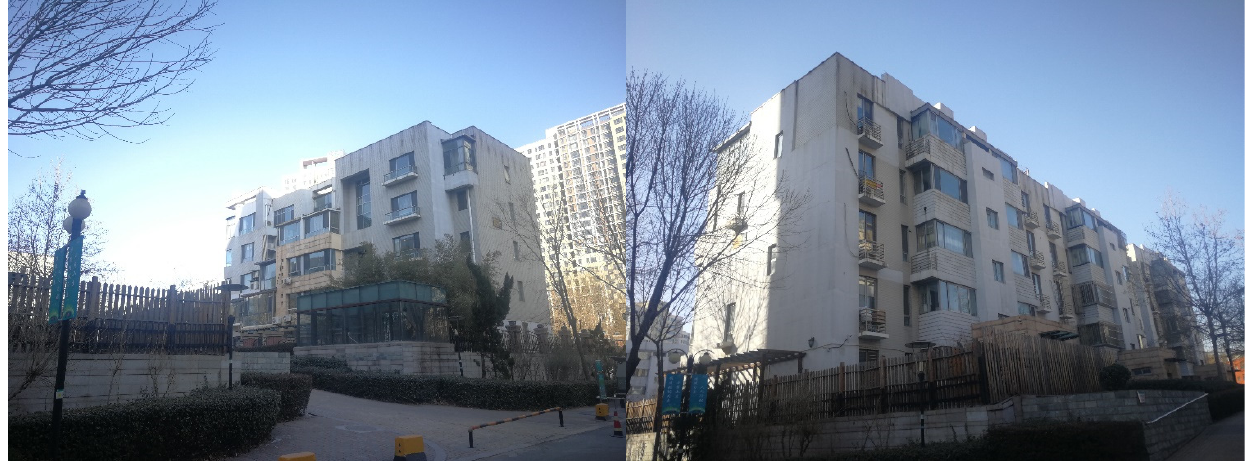
Figure 9. Actual photos of Tianjin Tianbao Gold Coast Community.